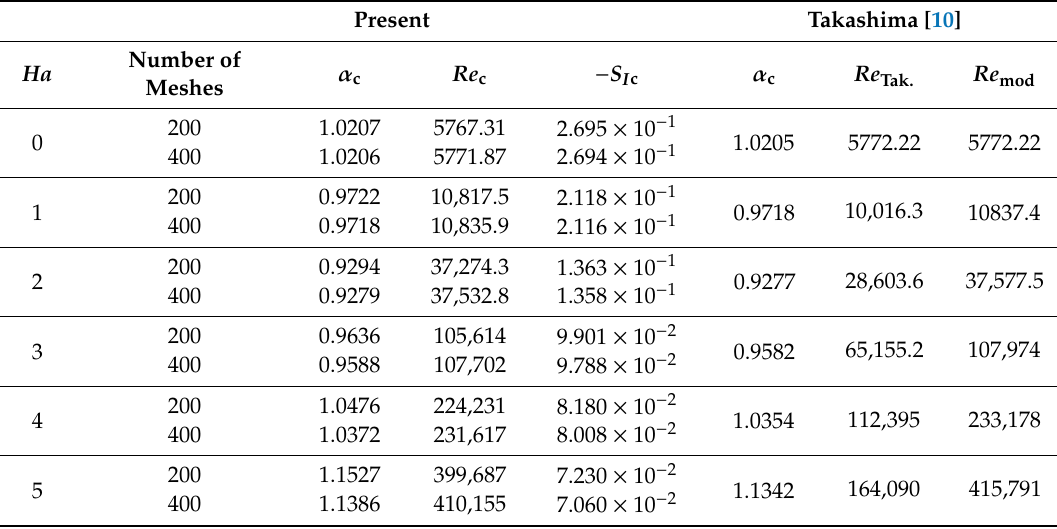
Table 2. Summary of the critical values obtained for several values of Hartmann number. Dependency on the number of meshes and the comparison with Takashima’s results are shown.